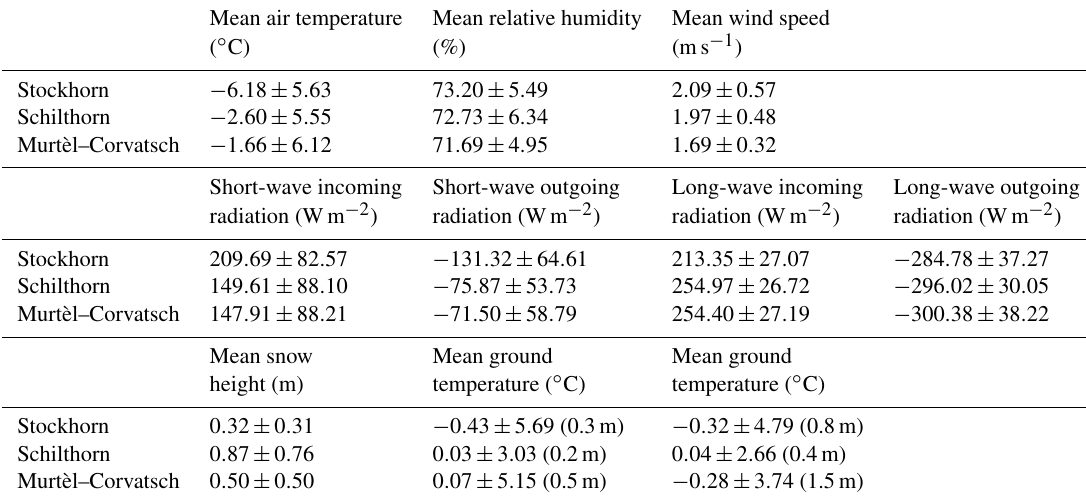
Table 3. Mean values and standard deviation for the climate variables calculated based on the mean monthly values and the time period of measurements.